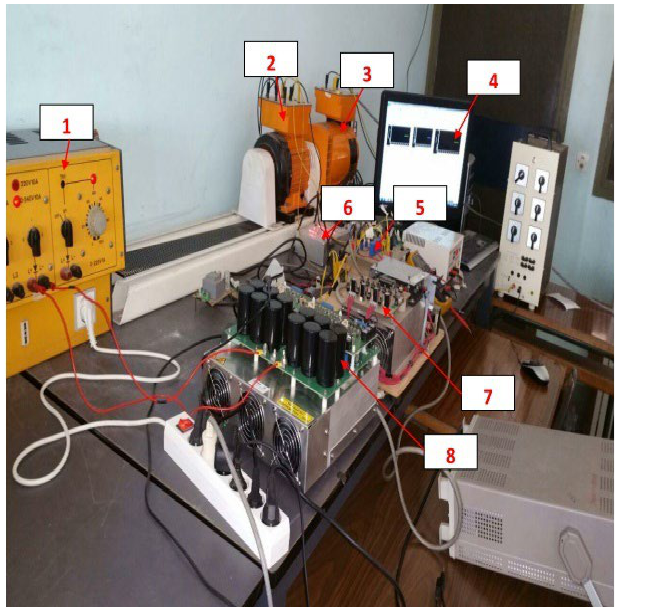
Figure 13. Photography of the experimental platform.